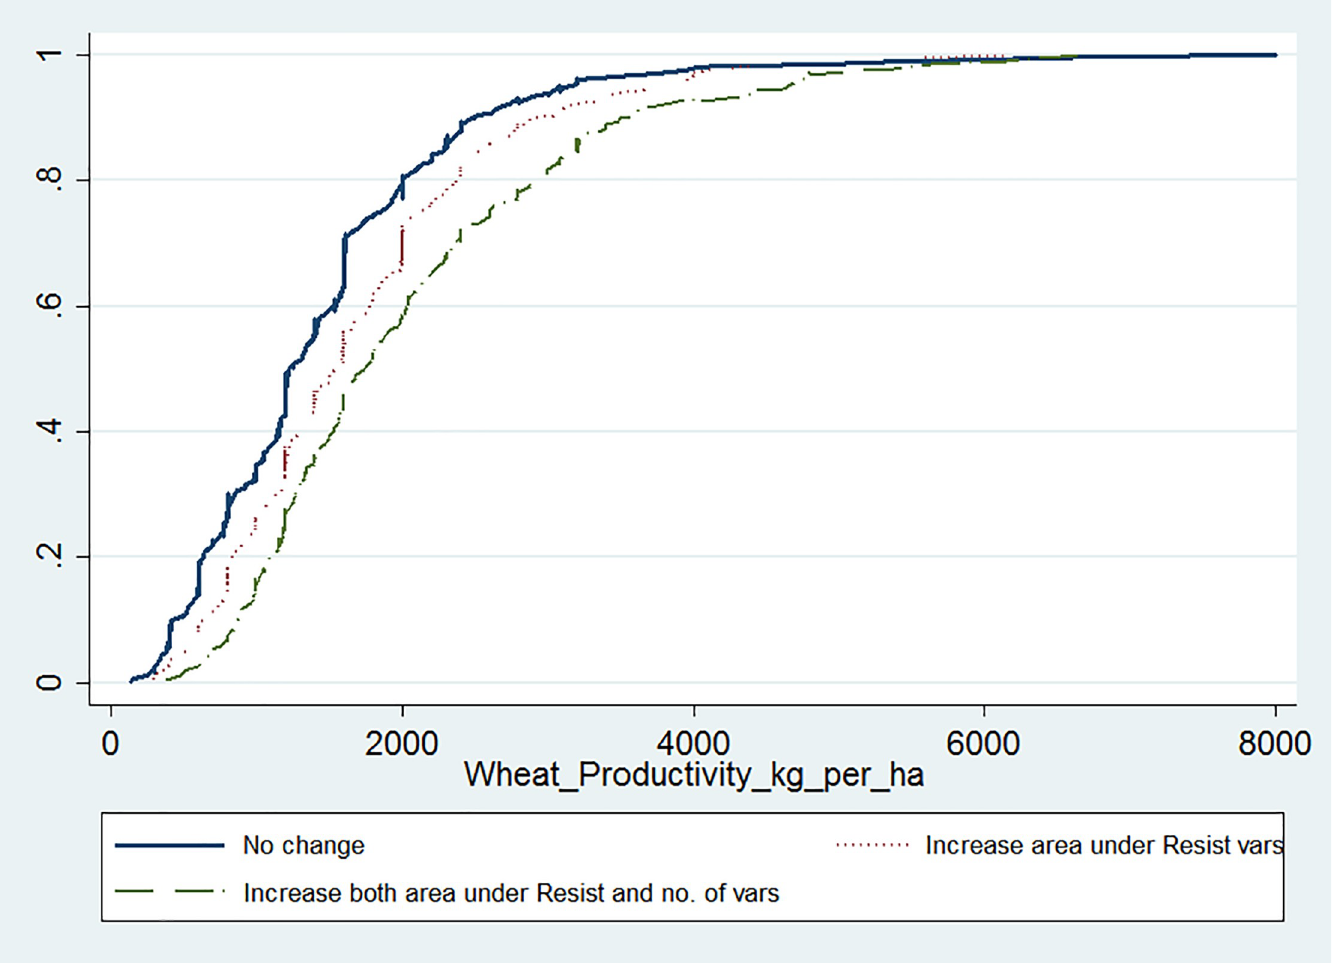
Fig 3. Cumulative distribution of wheat productivity (kg/ha, self-reported) for different wheat rust coping mechanisms, Ethiopia (2013/14 survey).